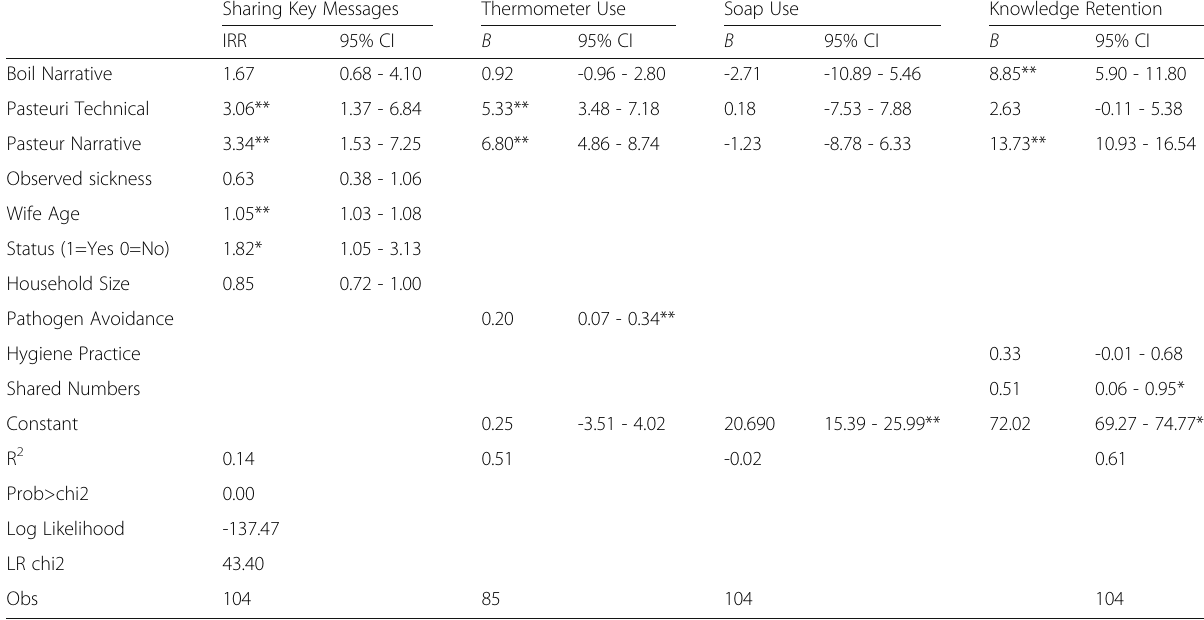
Table 1 Reduced models for household intervention outcomes. IRR is incidence rate ratios from negative binomial regression while B are beta coefficients from OLS. R 2 for sharing key messages is pseudo R 2 and adjusted R 2 for OLS